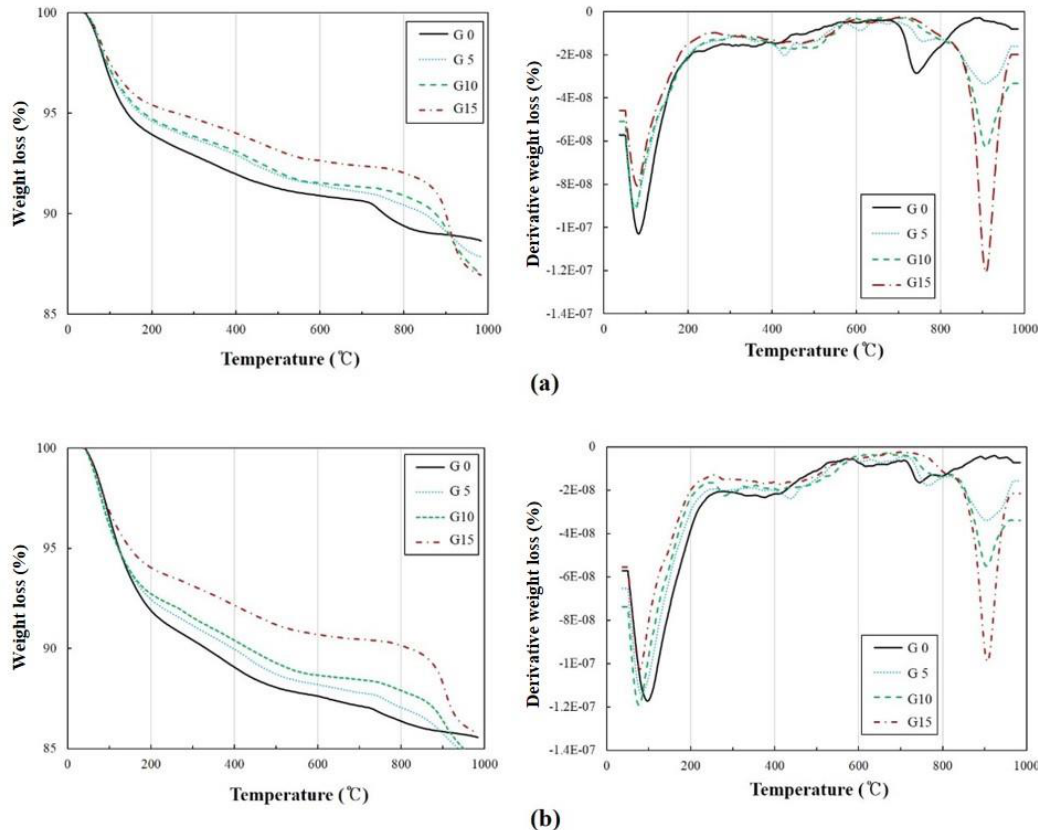
Figure 5. Thermogravimetric (TG)/DTG results on the ( a ) 7th day and ( b ) 28th day.